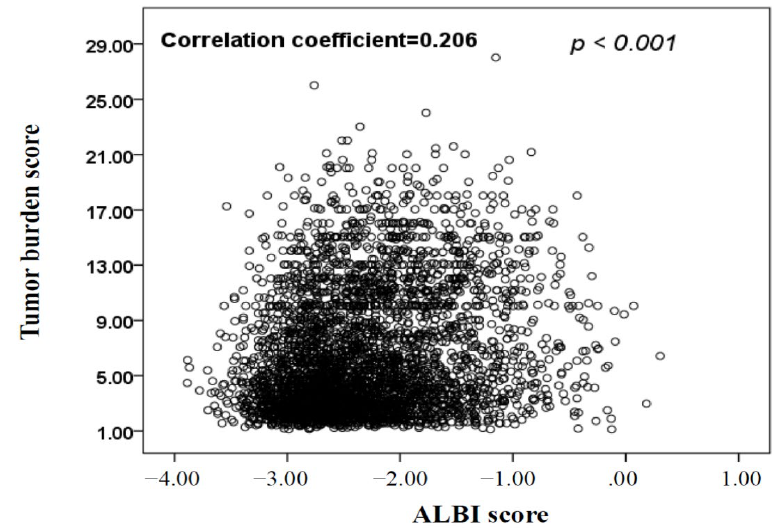
Figure 1. The correlation between tumor burden score (TBS) and albumin–bilirubin (ALBI) score. There was weak but significant correlation between TBS and ALBI score (correlation coefficient = 0.206, p < 0.001; n=3794). Table 1. Baseline demographics ( n = 3,794).